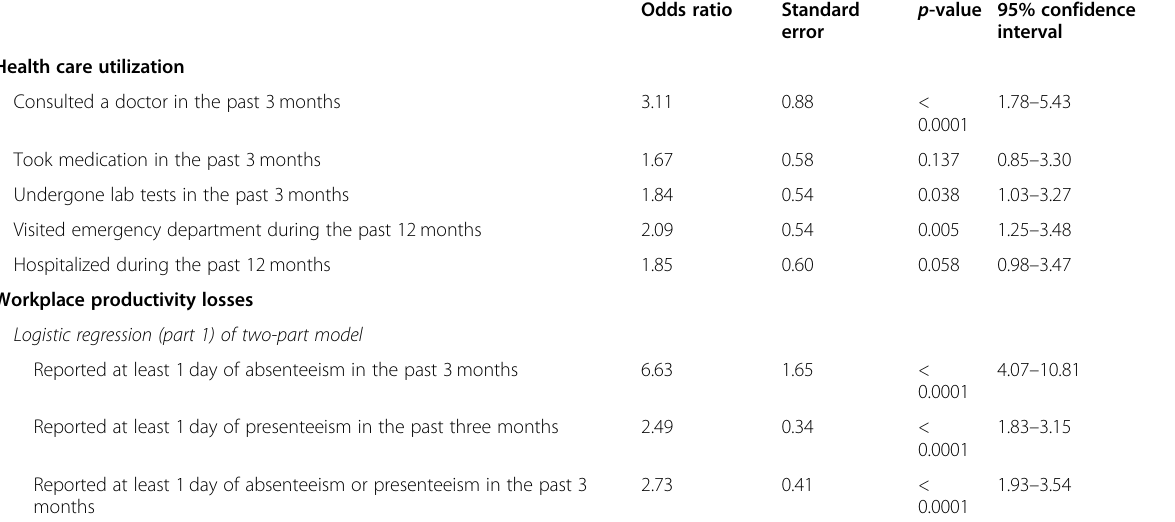
Table 2 Associations of health care utilization and workplace productivity losses with migraine disability (high or MIDAS III/IV vs low or MIDAS